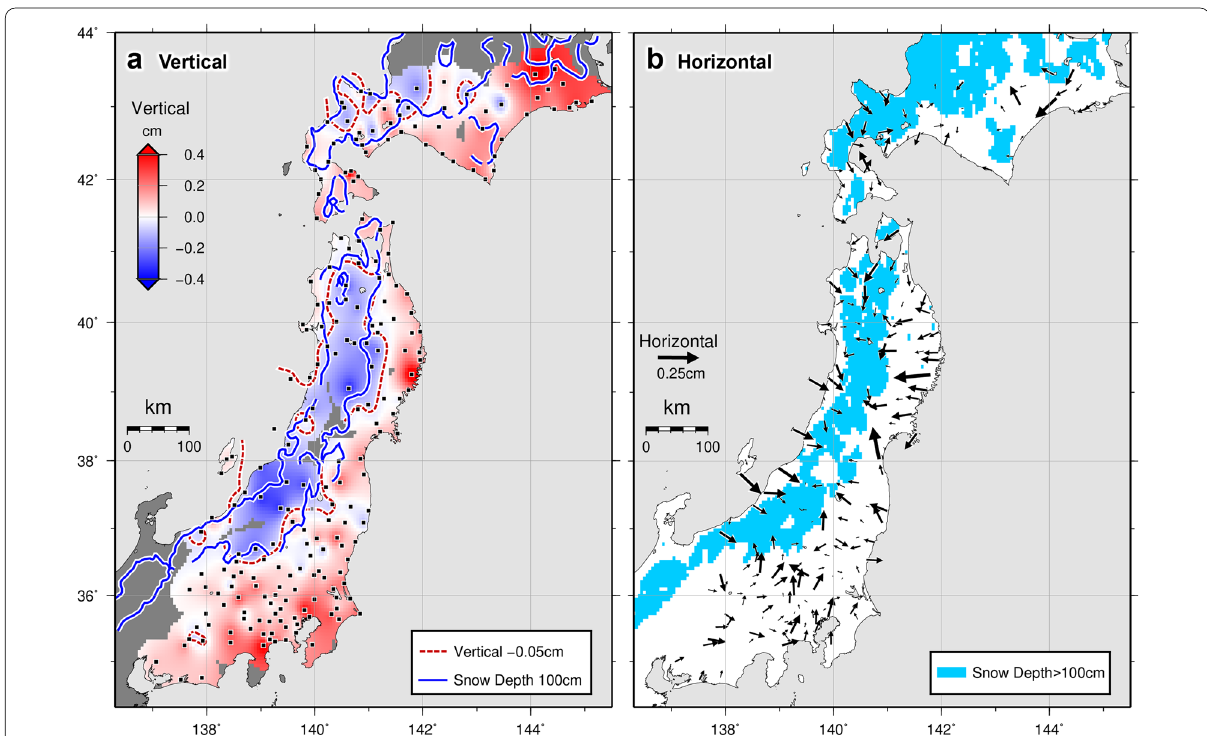
Fig. 15 Discernment of crustal deformation caused by snow-cover load using the functional model. a Vertical component of normal value of deviation from the functional model in early March. The red dashed line represents a contour of the average annual maximum snowfall is 100 cm (Ministry of Land, Infrastructure, Transport and Tourism 2012). Black squares represent GNSS stations used in this study. b Horizontal component of normal value of deviation from the functional model in early March. Blue areas represent locations, where the average annual maximum snowfall is > 100 cm. Both figures use the average values for 10 days around March 11 of each year from 2012 to 2020 (excluding